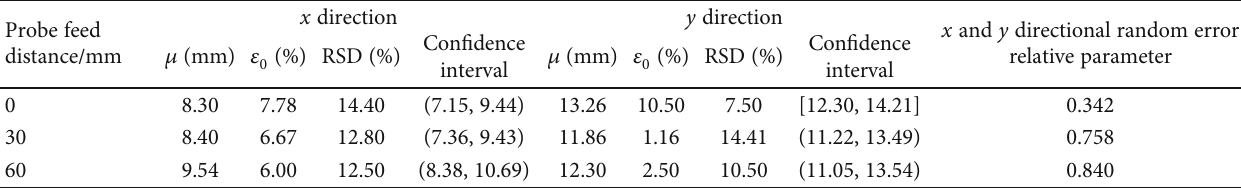
Table 3: Analysis result of azimuth angle of remote center point error.